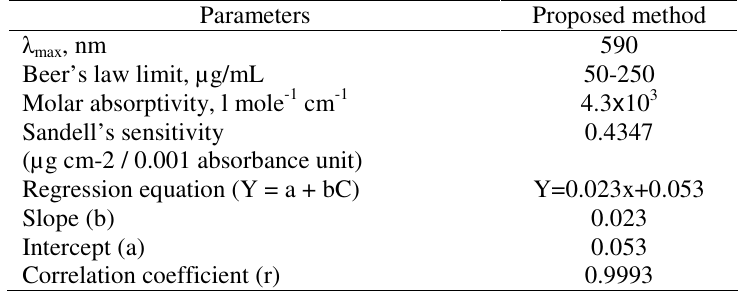
Table 1. Optical characteristics of proposed method